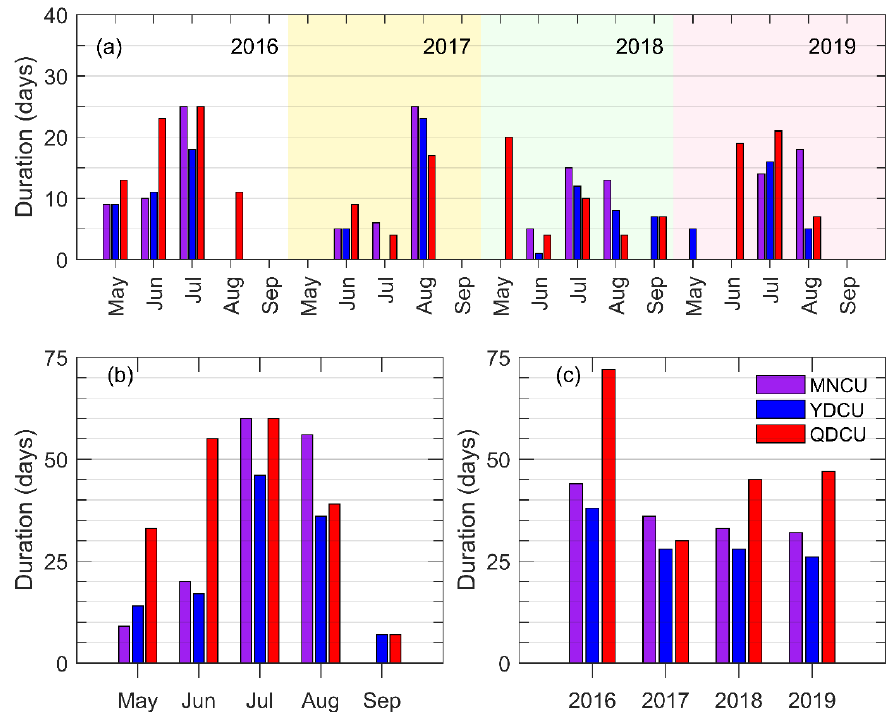
Figure 6. The inter-monthly variation and the inter-annual variation of upwelling’s duration. ( a ) The upwelling duration in each month during the boreal summers of 2016–2019; ( b ) the monthly mean upwelling duration regardless of the year; ( c ) the total upwelling duration in May–September of each